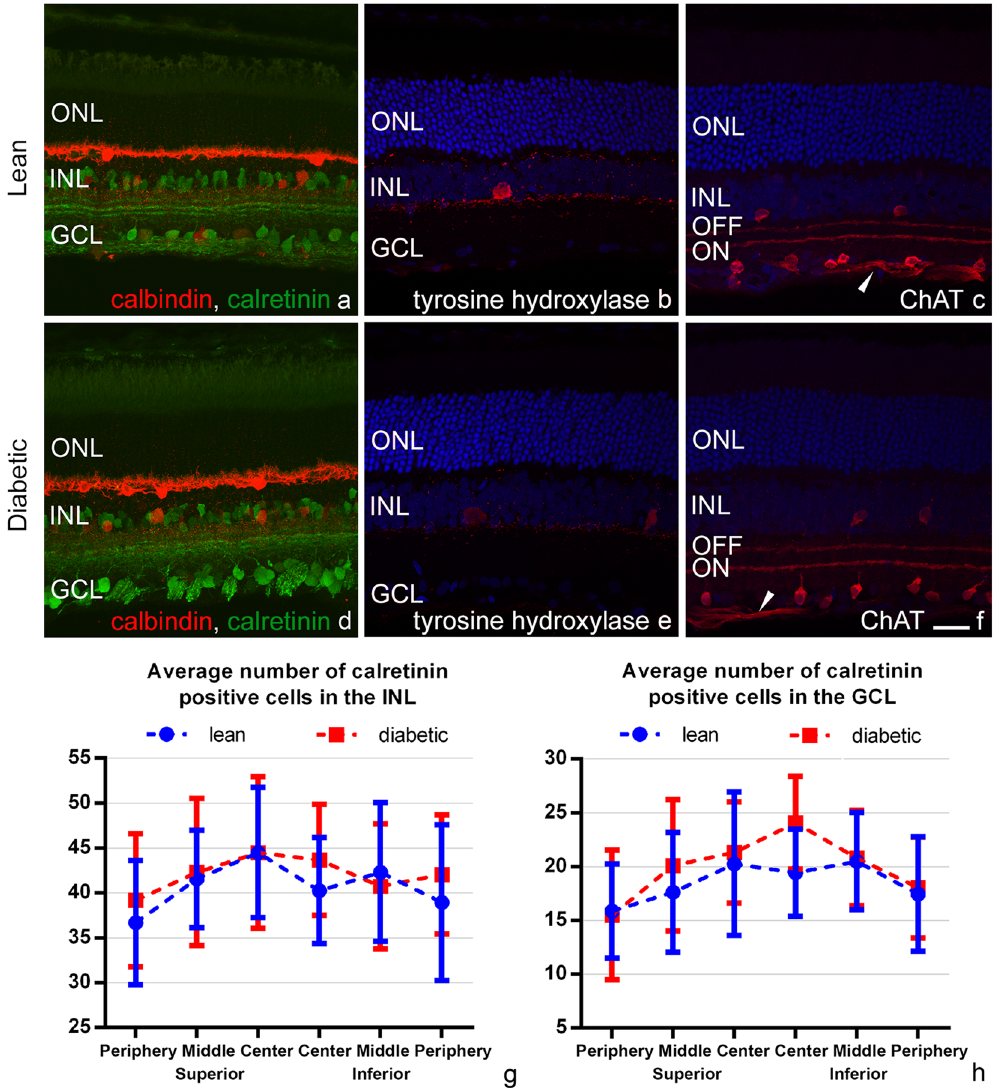
Figure 8. Staining patterns for calbindin, calretinin, tyrosine hydroxylase and choline acetyltransferase (ChAT) antibodies in lean (upper row) and diabetic rat retinas (lower row). Calbindin ( a , d , in red) stains horizontal cells, and a few cells in the INL and GCL. Calretinin ( a , d , in green) is a frequently used marker for some ganglion cells, amacrine and displaced amacrine cells, with processes terminating in three distinct layers of the IPL. No change in staining intensity or in the number of stained cells was evident for these two antibodies. Quantification for calretinin positive cells are given in g and h . Antibody against tyrosine hydroxylase ( b , e , in red) labels dopaminergic amacrine cells. A slight decrease in staining intensity was detectable in diabetes ( e ). ChAT antibody ( c , f in red) labels mostly cholinergic starburst amacrine cells, along with some axons in the nerve fibre layer (arrowheads) and possibly some ganglion cells also. No change was evident in diabetes. DAPI is used as a nuclear staining. ONL: outer nuclear layer, INL: inner nuclear layer, GCL: ganglion cell layer, ON and OFF: sublayers of the IPL. Bar : 20 μ